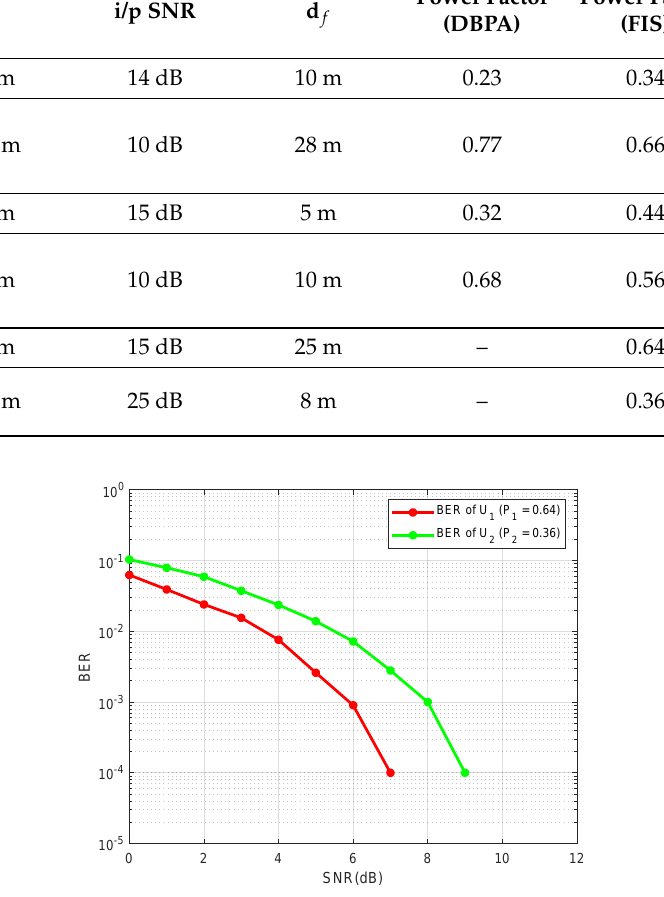
Figure 14. Performance analysis for two users in the proposed FIS based system where U 1 is assigned a maximum power factor and U 2 a minimum power